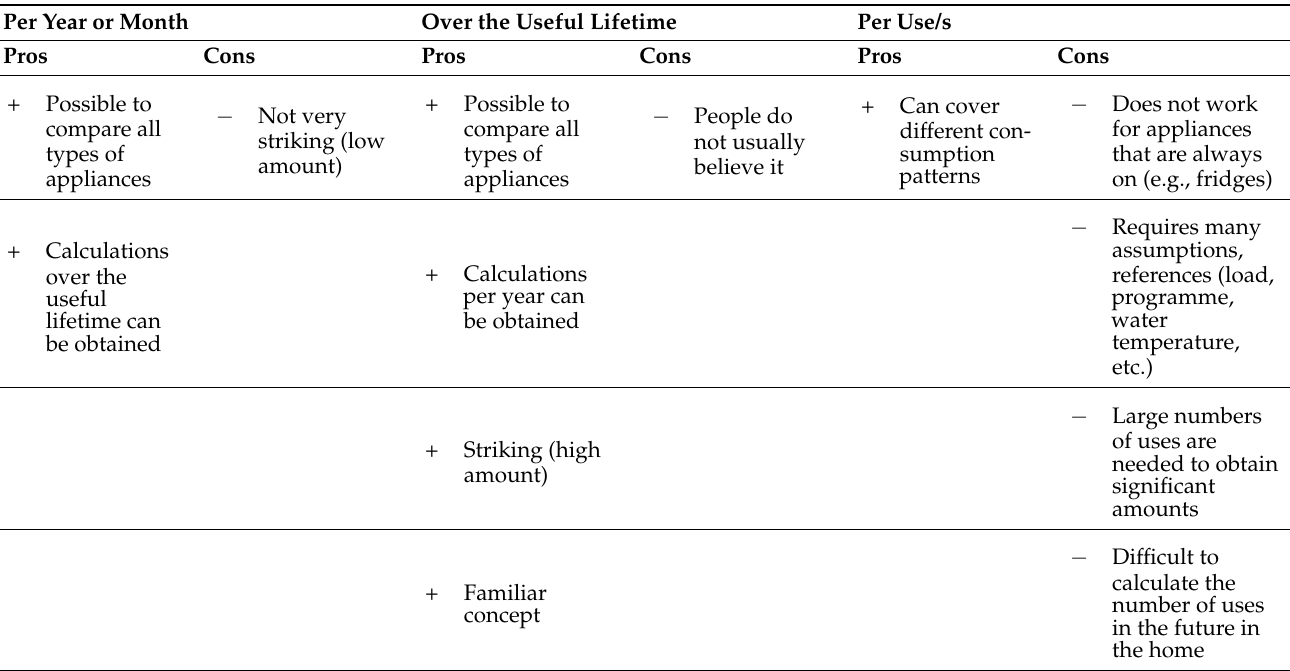
Table 3. Arguments for and against the three types of units according to the interviews with members of the public, retailers and